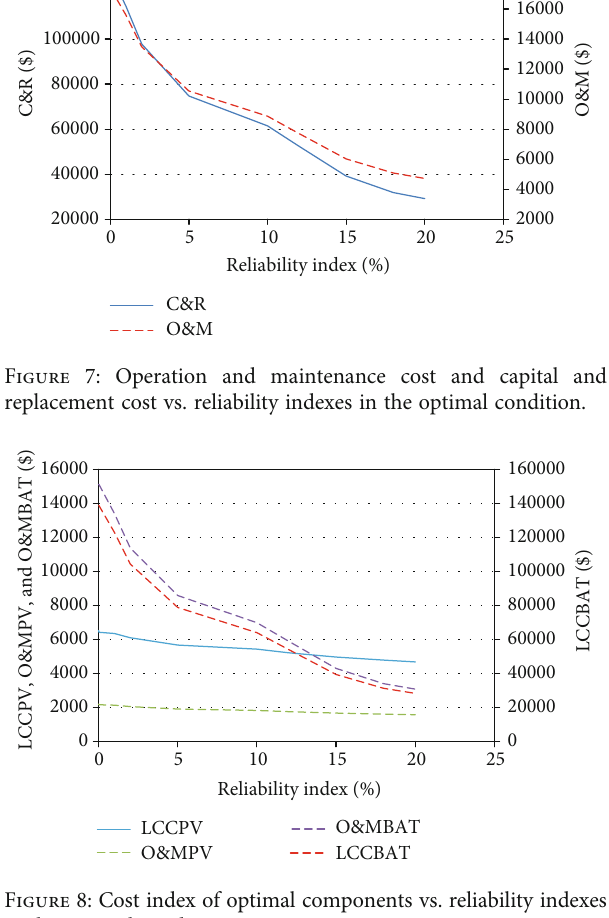
Figure 6: Number of optimal components vs. system reliability indexes.